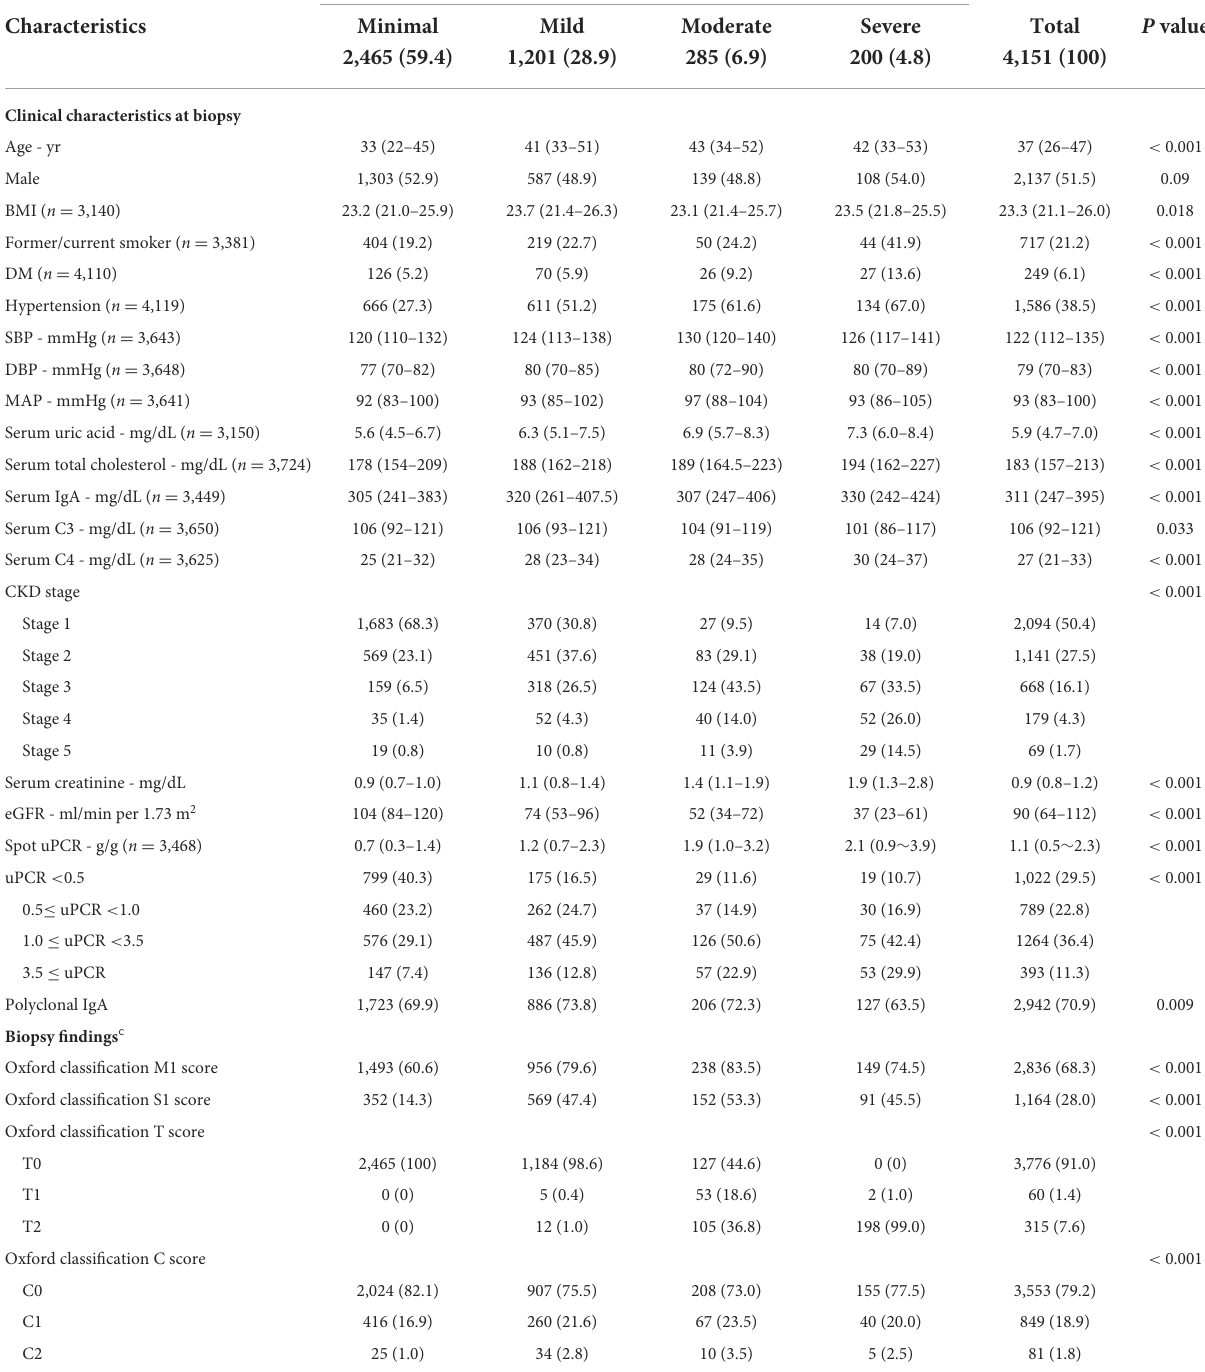
TABLE 1 Baseline characteristics of 4,151 patients with IgA nephropathy, categorized by chronicity grading a